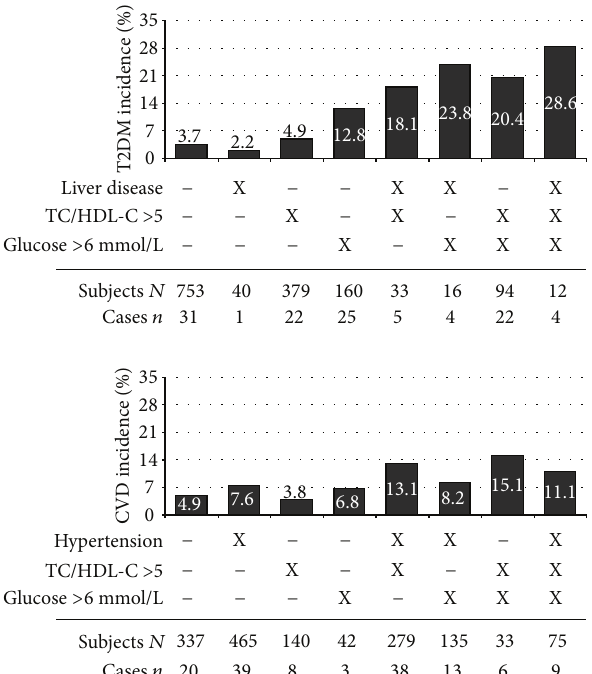
Figure 1: Incidence of type 2 diabetes mellitus (T2DM) and cardiovascular disease (CVD) depending on important risk factors including liver disease (only for diabetes), hypertension (only for CVD), increased total cholesterol—high-density lipoprotein cholesterol ratio (TC/HDL-C > 5), and increased glucose levels ( >